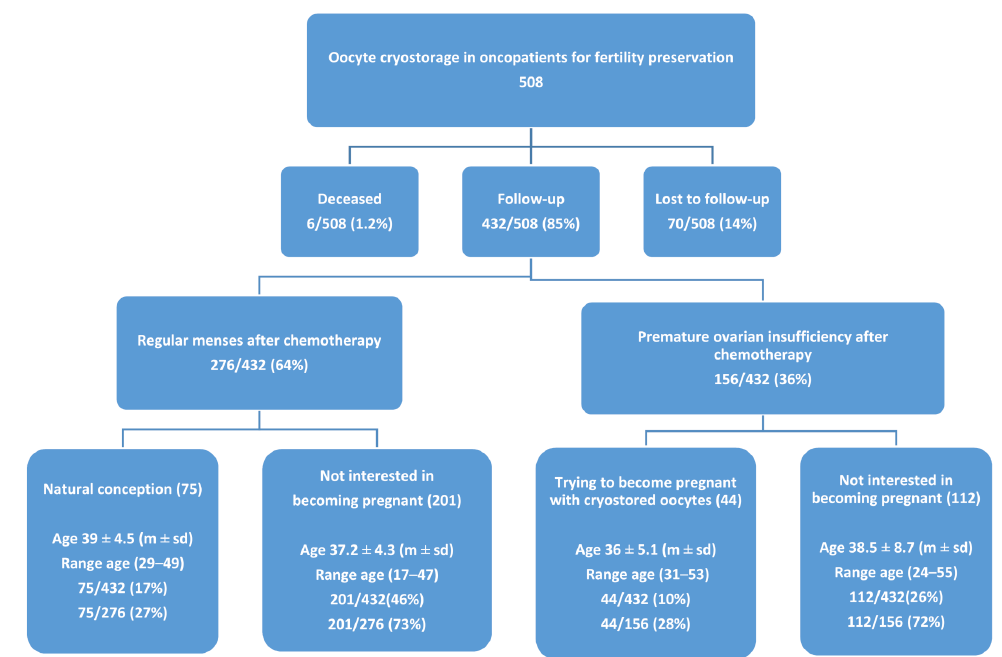
Figure 1. Flowchart of follow-up in oncological patients enrolled in the study. Of the patients, 70/508 (14%) did not complete the follow-up required by the study, 6/508 (1.2%) deceased (2 had hematological cancer, 1 had astrocytoma, 1 had ependymoma, and 2 had breast cancer), and 432/508 (85%) completed the follow-up. In total,